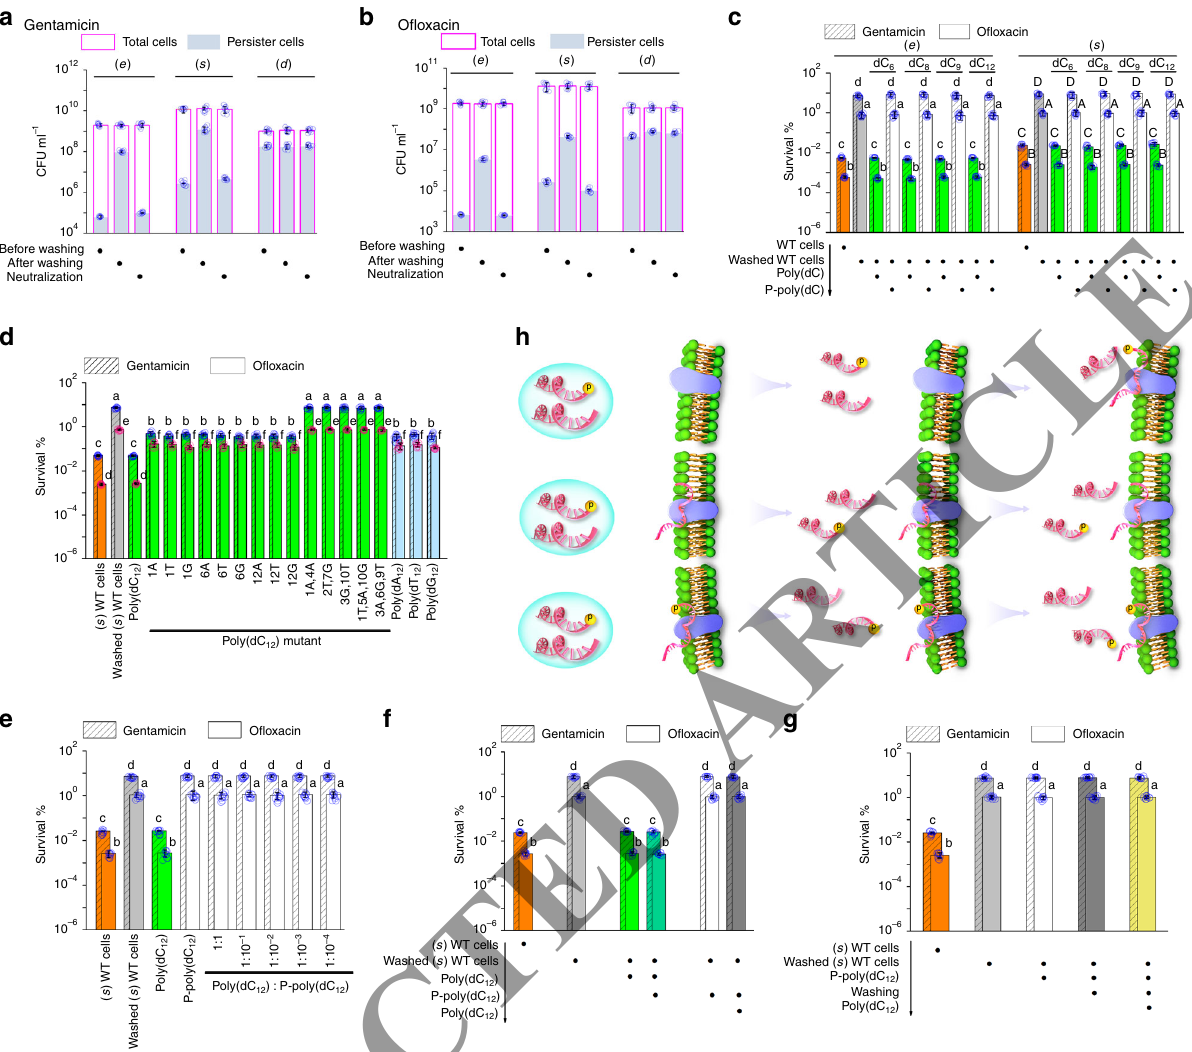
Fig. 1 Extracellular poly(dC) modulates PAO1 persistence. a , b The number of total and persister cells before and after washing ( e ), ( s ), or ( d ) WT cells as well as after resuspending corresponding washed cells in their native supernatants (neutralization). c Persistence in washed ( e ) WT cells or washed ( s ) WT cells plus short poly(dC) or P-poly(dC). Poly(dC) instead of P-poly(dC) reduced persistence in washed ( e ) WT cells and washed ( s ) WT cells. d Persistence in washed ( s ) WT cells plus each poly(dC 12 ) mutant, poly(dA 12 ), poly(dT 12 ), or poly(dG 12 ). These ssDNA led to a nearly 10-fold reduction in persistence of washed ( s ) WT cells. As a control, poly(dC 12 ) caused a more than 100-fold reduction in persistence of washed ( s ) WT cells. e Persistence in washed ( s ) WT cells plus poly(dC 12 ) and P-poly(dC 12 ) with different molar ratios. P-poly(dC 12 ) abolished the regulatory activity of poly(dC 12 ) in persistence of washed ( s ) WT cells. f Persistence in washed ( s ) WT cells plus poly(dC 12 ) for 10 min and then P-poly(dC 12 ) for 10 min or plus P-poly(dC 12 ) for 10 min and then poly(dC 12 ) for 10 min. P-poly(dC 12 ) did not regulate persistence in poly(dC 12 )-pretreated washed ( s ) WT cells and vice versa. g Persistence in washed ( s ) WT cells plus P-poly(dC 12 ) for 10 min, washing again, and then plus poly(dC 12 ) for 10 min. These treatments did not reduce persistence in washed ( s ) WT cells. h Proposed model for functional antagonism between poly(dC) and P-poly(dC). All experiments were performed in biological triplicates. Error bars represent standard deviations. Dot plots overlaid on bar graphs represent individual data points. Black spot, treatment